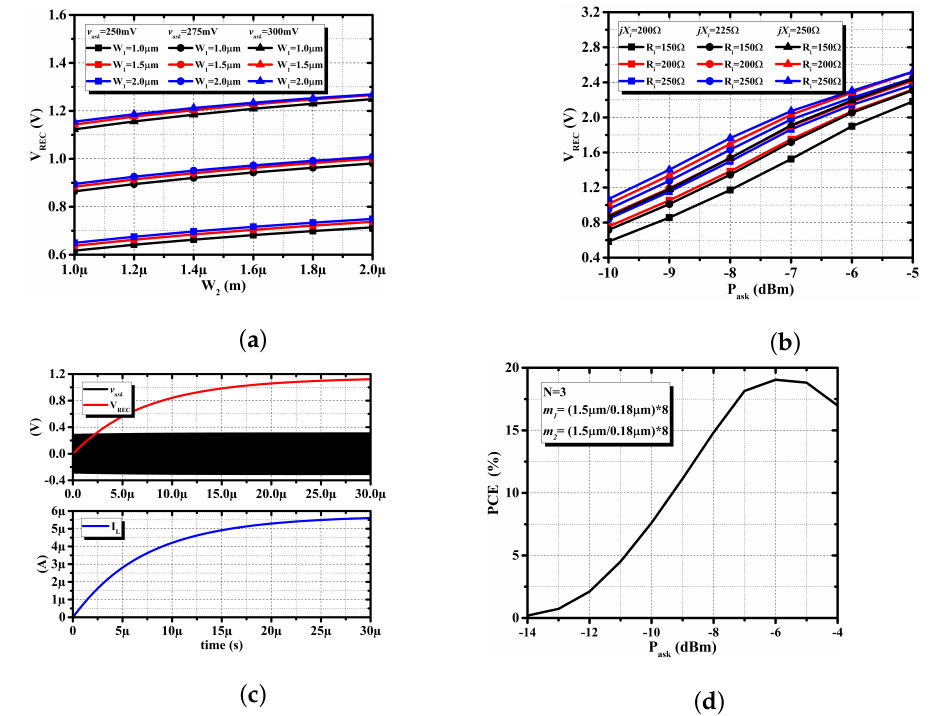
Figure 21. Power harvester post-layout simulation. ( a ) Parametric sweep for W 1 and W 2 . ( b ) Impedance sweep. ( c ) Start-up simulation. ( d ) Power conversion efficiency.